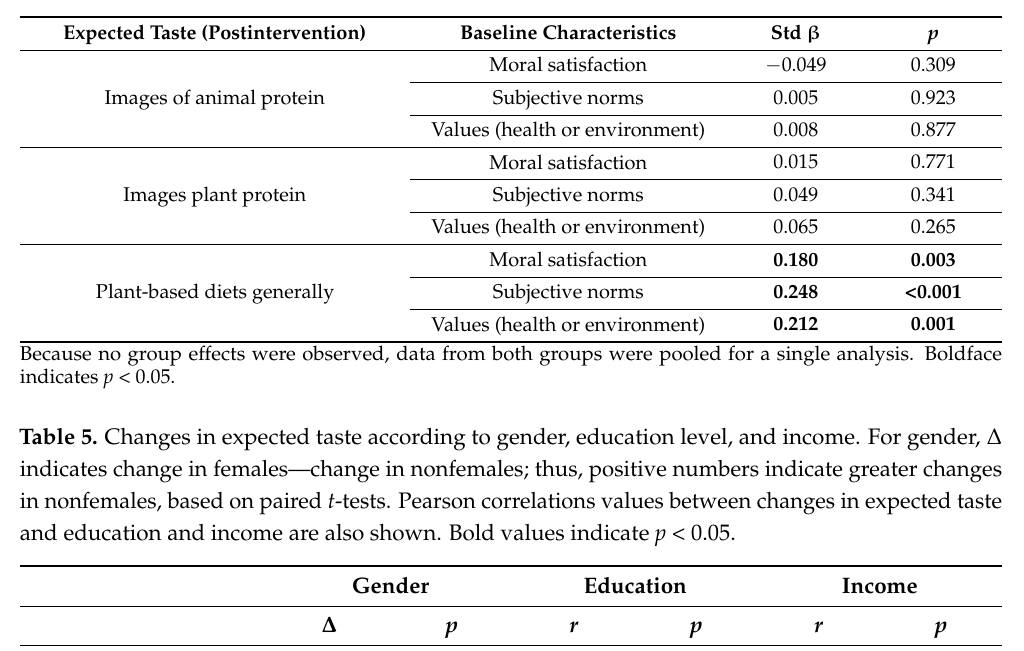
Table 4. Influence of baseline person-related factors on changes in expected taste following the text message intervention.